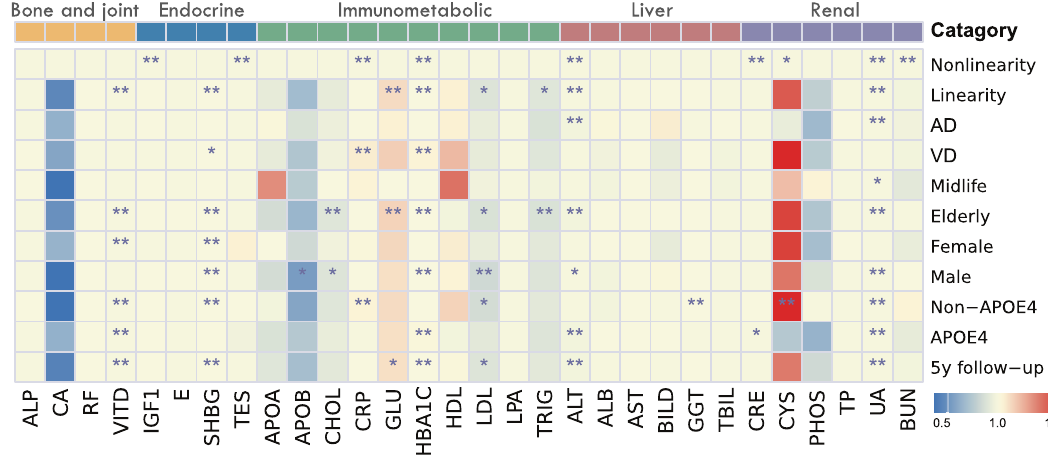
Fig. 4 Heatmap to overview the associations of serum laboratory tests with dementia risks. Heatmap overview the results of restricted cubic spline models, Cox models in whole cohort for dementia and two dementia subtypes (Alzheimer disease and vascular dementia), sensitivity analysis (Cox models in midlife, elderly, female, male, APOE ε 4 non-carrier, APOE ε 4 carrier and follow-up time more than 5 years cohort, respectively). * p < 0.05, ** p < 0.01. ALP Alkaline phosphatase, CA Calcium, RF Rheumatoid factor, VITD Vitamin D, IGF1 IGF-1; E Oestradiol, SHBG Sex hormone-binding globulin, TES Testosterone, APOA Apolipoprotein A, APOB Apolipoprotein B, CHOL Cholesterol, CRP C-reactive protein, GLU Glucose, HBA1C Glycated haemoglobin, HDL HDL cholesterol, LDL LDL cholesterol, LPA Lipoprotein A, TRIG Triglycerides, ALT Alanine aminotransferase, ALB Albumin, AST Aspartate aminotransferase, BILD Direct bilirubin, GGT Gamma glutamyltransferase, TBIL Total bilirubin, CRE Creatinine, CYS Cystatin C, PHOS Phosphate, TP Total protein, UA Urate, BUN Urea, APOE4 apolipoprotein E ε